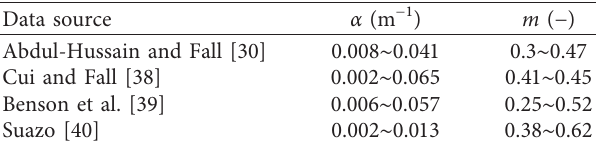
Table 3: Comparison of WRC model parameters collected from the literature.